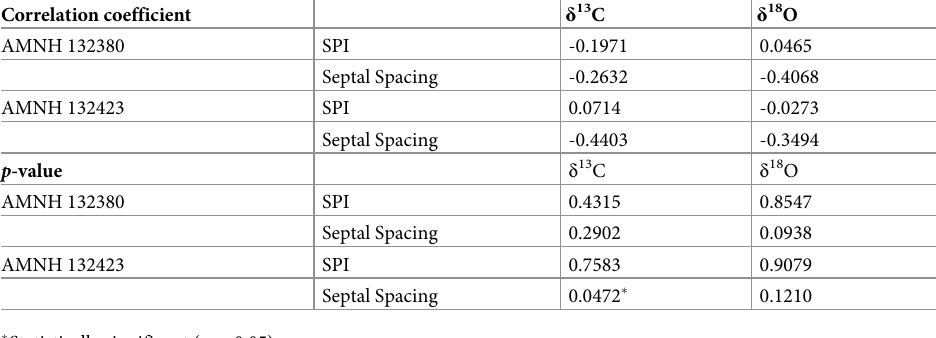
Table 2. Spearman’s rank correlation coefficients between morphological parameters septal spacing and siphun- cle position index (SPI) and isotopic values ( δ 18 O and δ 13